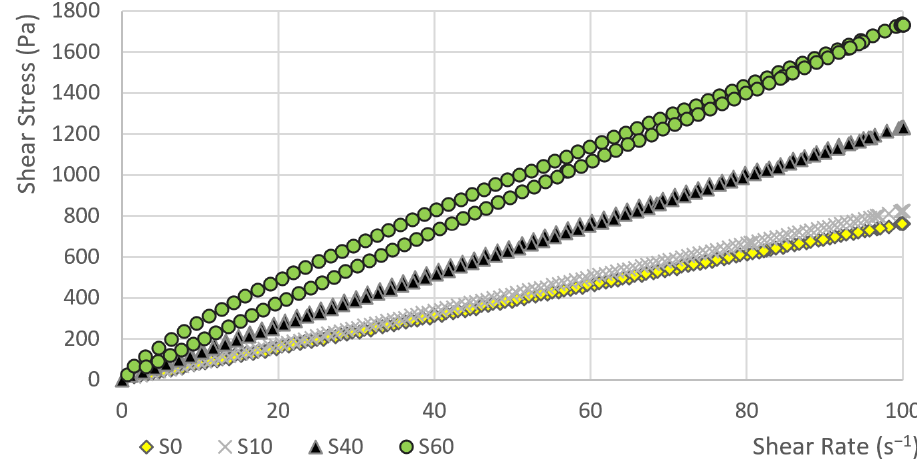
Figure 2. The dependence of the shear stress on the shear rate (sample: S0, S10, S40, S60).